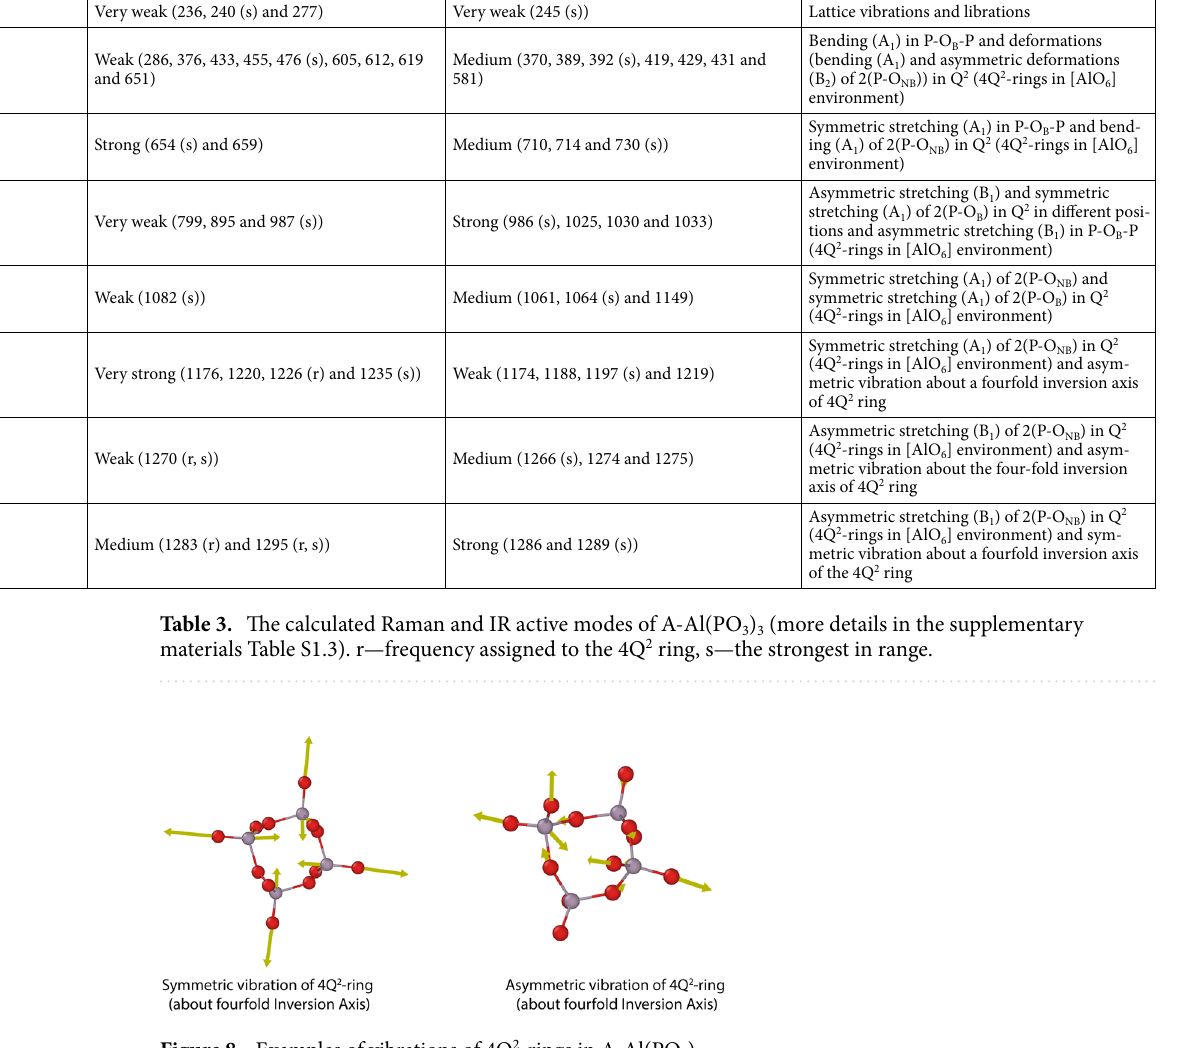
Figure 8. Examples of vibrations of 4Q 2 -rings in A-Al(PO 3 ) 3